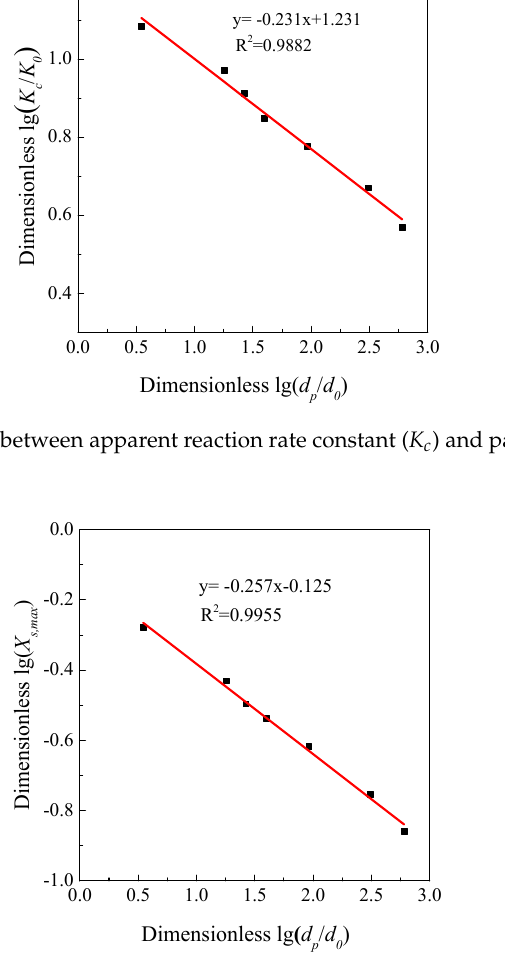
Figure 14. The relationship between X s,max and d p of Shengzhou limestone (500 ppm SO 2 ).